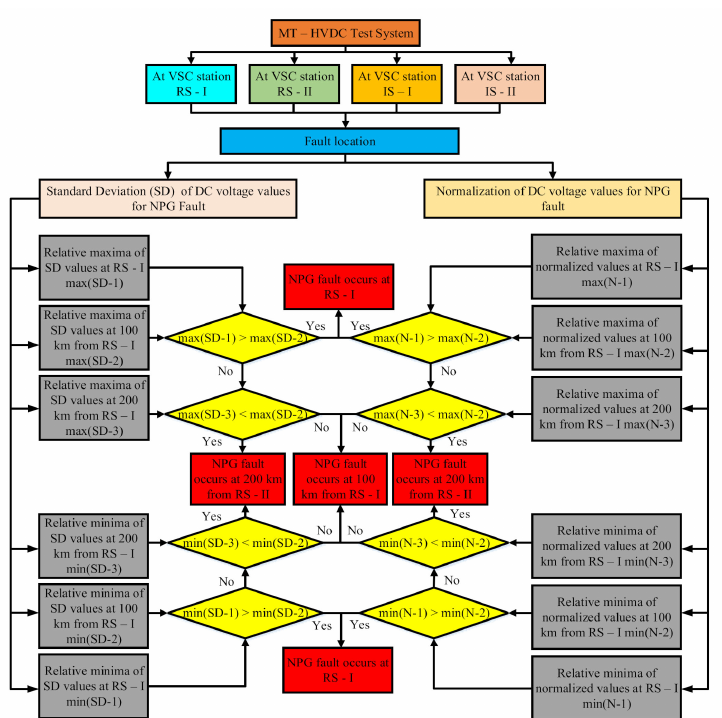
Figure 6. An algorithm for negative pole to ground (NPG) fault location finding based on SVM, using supported features of standard deviation and normalization of DC voltage.